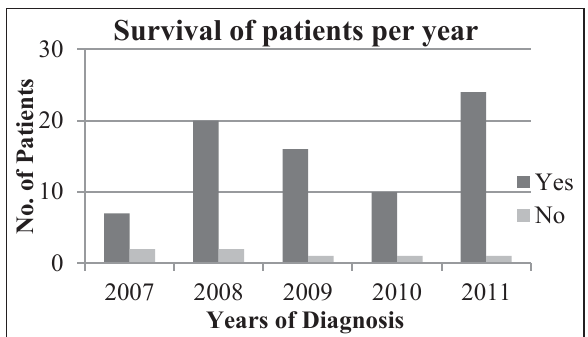
Fig-4: Survival outcomes of ALL